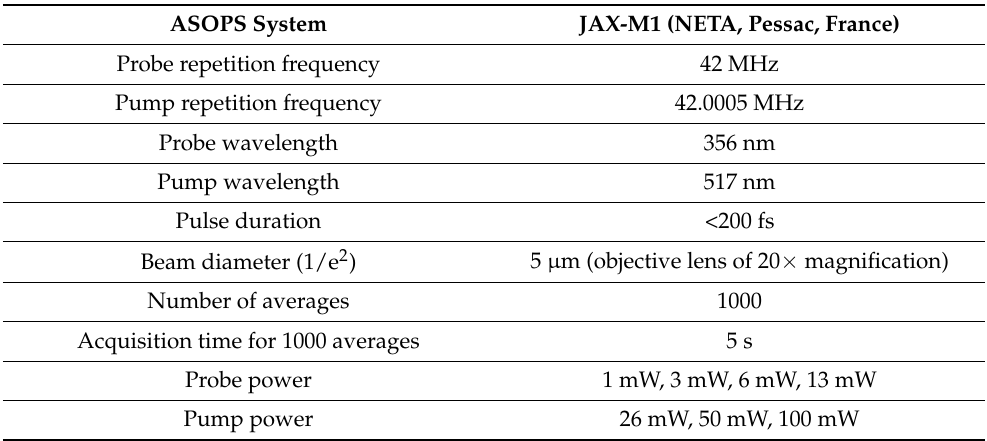
Figure 2. ( a ) Scheme of the experimental setup based on asynchronous optical sampling, where accumulating time delay between pump and probe femtosecond laser pulses is due to the difference in the repetition rate of two lasers. ( b ) Scheme of our TDBS experiment, where the absorption of the pump laser pulse in the Al film launches a coherent acoustic pulse (CAP) with a length of less than 25 nm in a low-k film and an Al layer. Scattering time-delayed probe light pulses by a CAP provides information on film properties in the current position of the CAP inside the film [2,3]. Particularly, the period of oscillating component in the presented time-domain transient optical reflectivity signals dR/R, as an inset in the screen of ( a ), is proportional to the product of local optical refractive index and sound velocity. ( c ) Illustration of the unwanted situation where the CAP propagating in Al after partial reflection at Si/Al interface reaches the Al/low-k film interface and transmits a second CAP in the low-k film, which would scatter probe light simultaneously with the first CAP. Table 2. Parameters of the experimental setup applied for TDBS